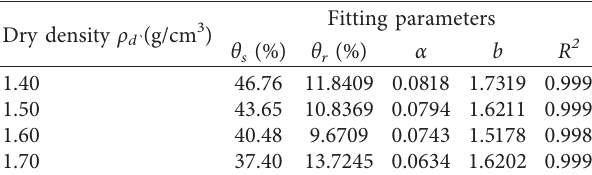
Table 4: Fitting parameters of the van Genuchten